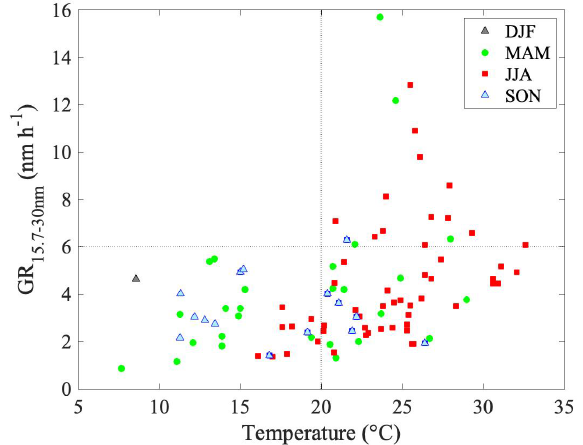
Figure 5. Growth rate (GR 15 . 7–30nm ) values as a function of am- bient temperature for different